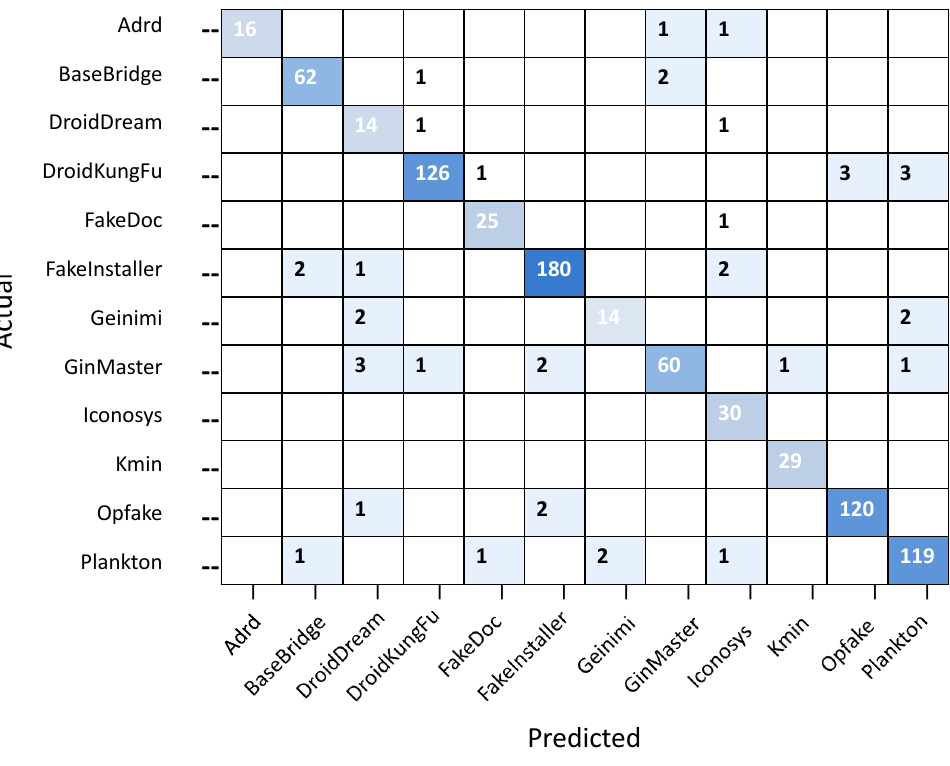
Figure 6. Proposed model classification performance measurement through confusion